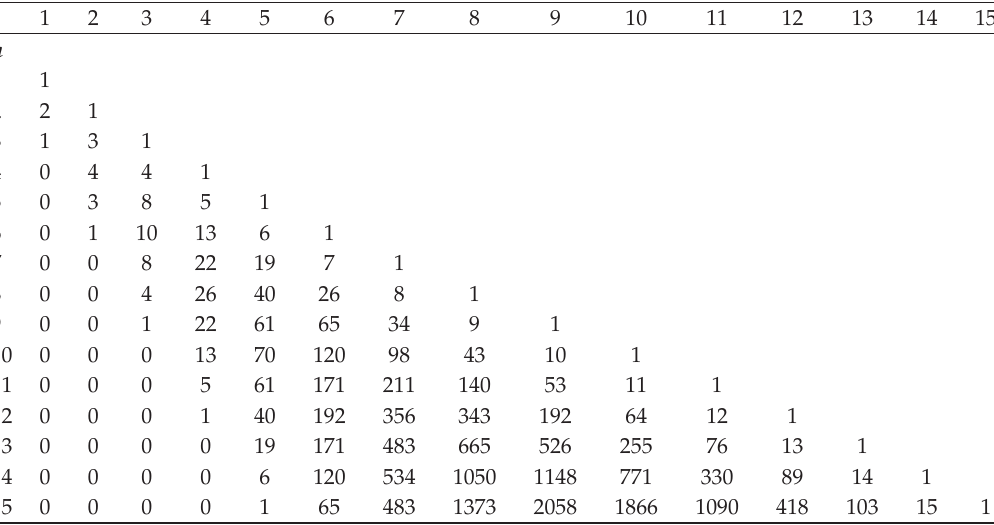
Table 1: d (cid:3) P n ,j (cid:4) , the number of dominating set of P n with cardinality j